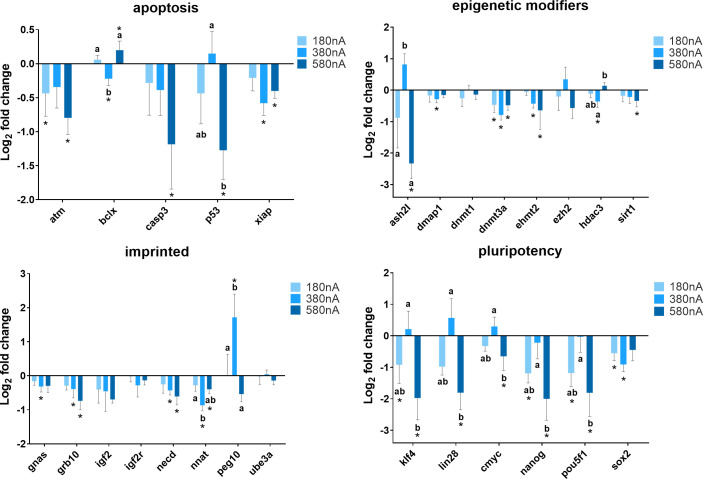
Summary of relative gene expression levels in fibroblast cells of Chamber I exposed to 180 nA, 380 nA, and 580 nA of electrical biostimulation for 21 hours.Graphs depicting the average log2 fold change values of every gene for each of the functional gene categories tested by qPCR using the BioMark system from Fluidigm. In each of these graphs, error bars reflect the standard error of the mean log2 fold change values calculated for four replicate reactions. * = significantly different from the control (the cells in Chamber III of the 180 nA, 380 nA, and 580 nA experiment, respectively). a,b,c = within a panel (gene category), different superscripts denote statistically significant differences in log2 fold change values between samples (P < 0.05).